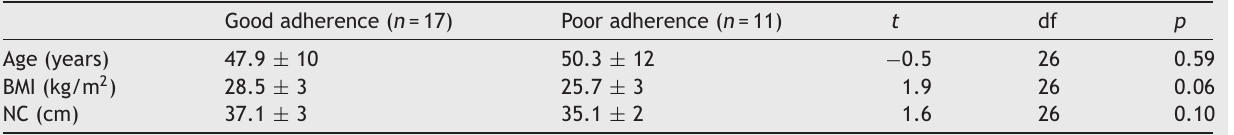
Comparison of clinical parameters between patients with good and poor adherence to MAD at baseline. Good adherence ( n =